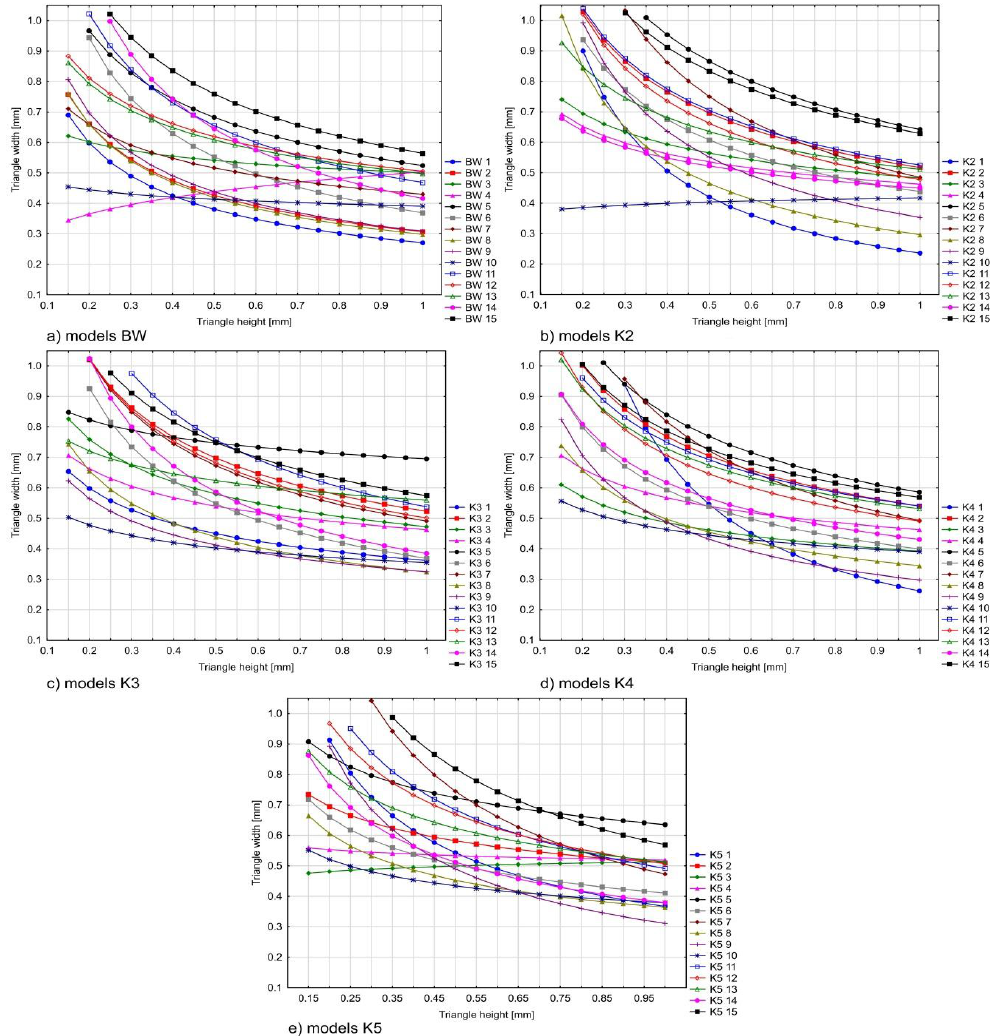
Figure 9. Regression models for single card types (BW and K2-K5). ( a ) Models BM; ( b ) Models K2; ( c ) Models K3; ( d ) Models K4; ( e ) Models K5.